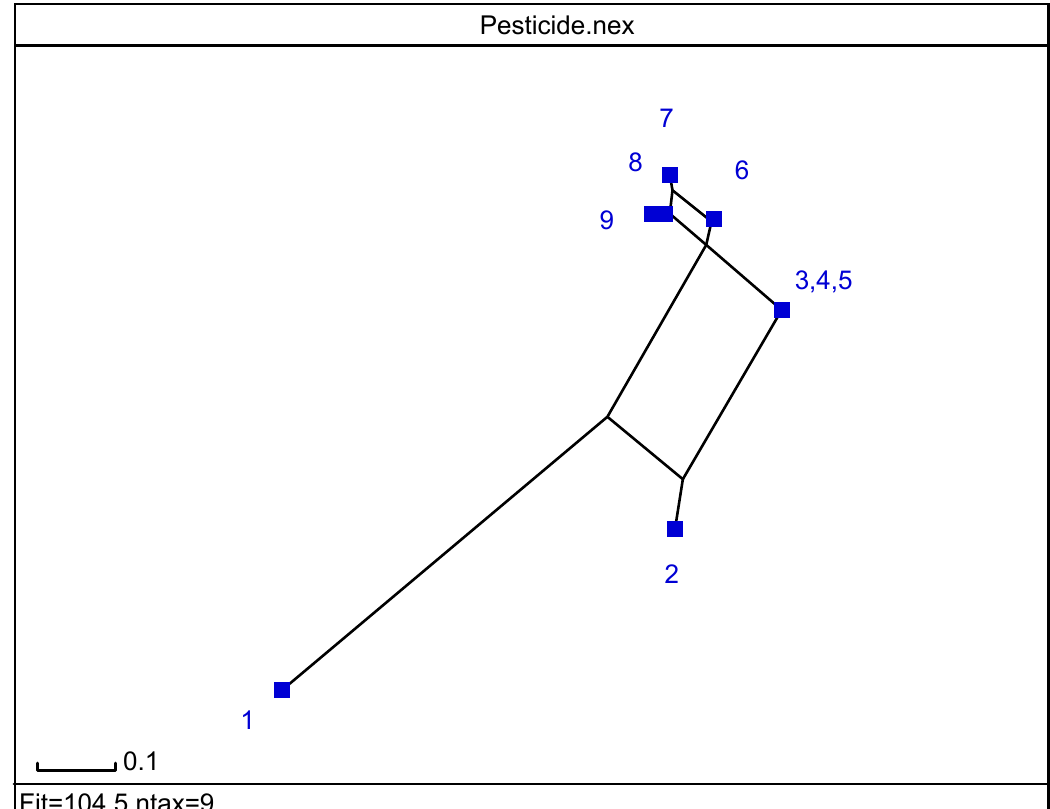
Figure 4. Splits graph of pesticides according, top → bottom , to: